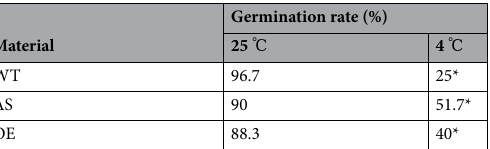
Table 1. Effects of different temperature on seed germination characteristics of maize. Note: compared with normal temperature control, "*" indicate by the t-test analysis, P <